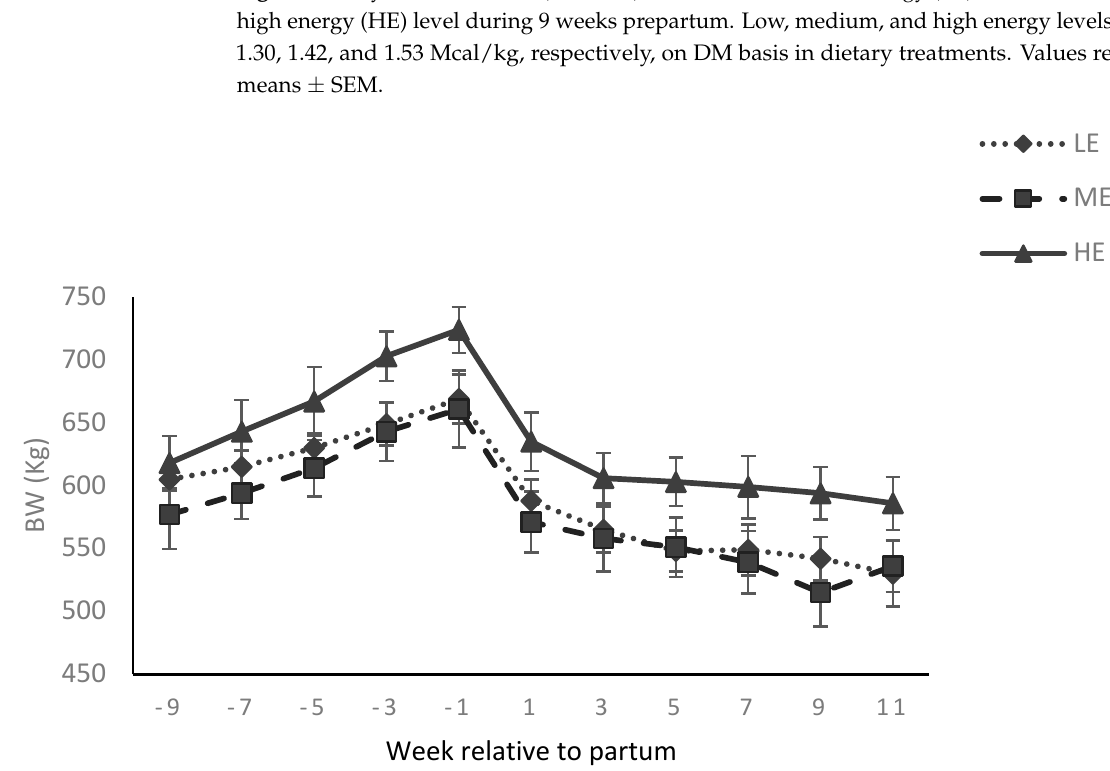
Figure 4. Body weight (BW; kg) of Nili Ravi buffaloes fed a low energy (LE), medium energy (ME) or high energy (HE) level during 9 weeks prepartum. Low, medium, and high energy levels were NE L : 1.30, 1.42, and 1.53 Mcal/kg, respectively, on DM basis in dietary treatments. Values represent LS means ± SEM.